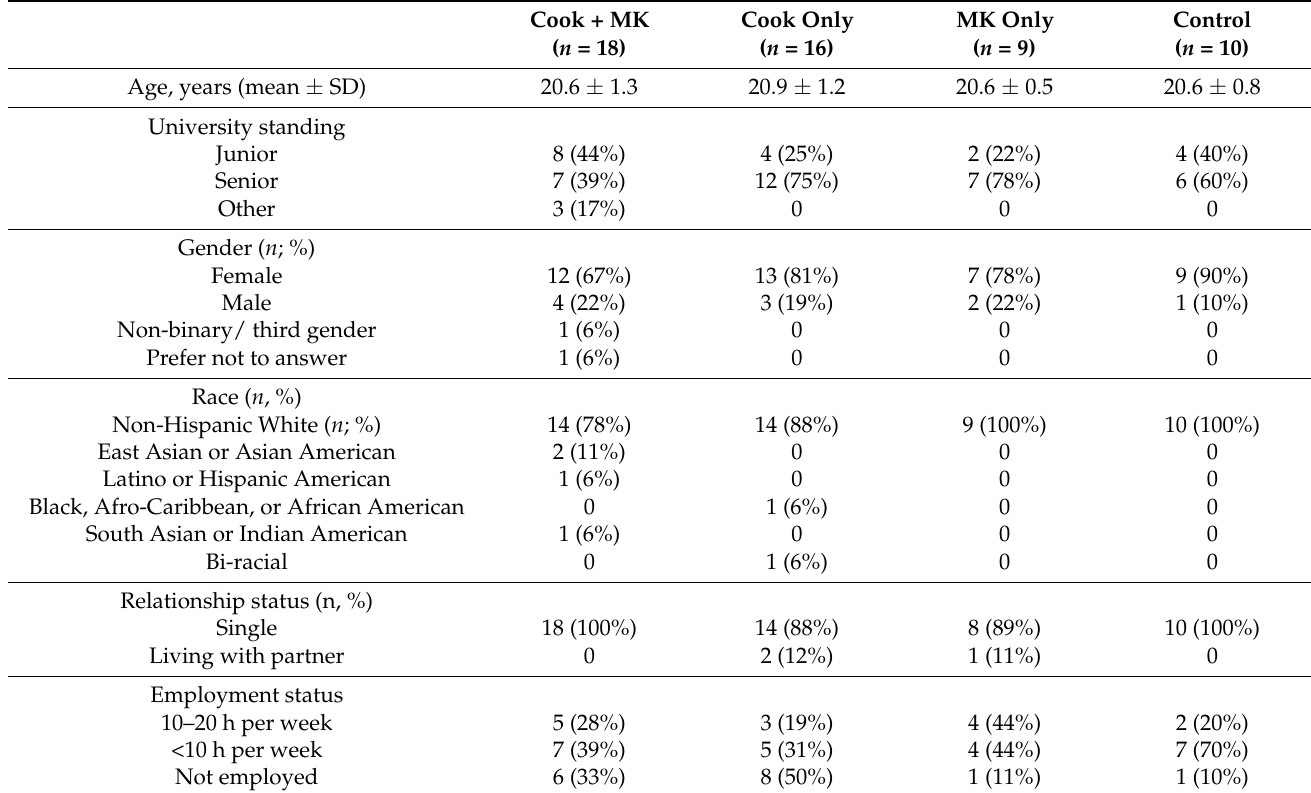
Table 1. Demographic characteristics of participants.